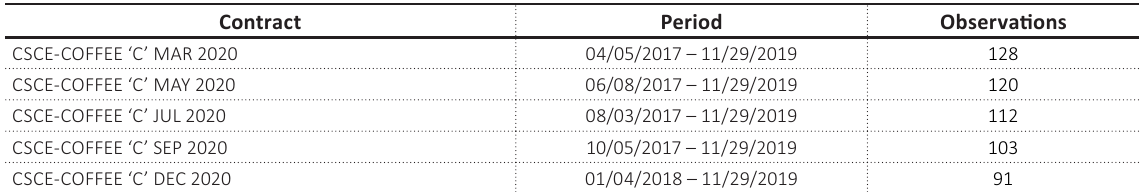
Source: Authors’ calculations from Thomson Reuters